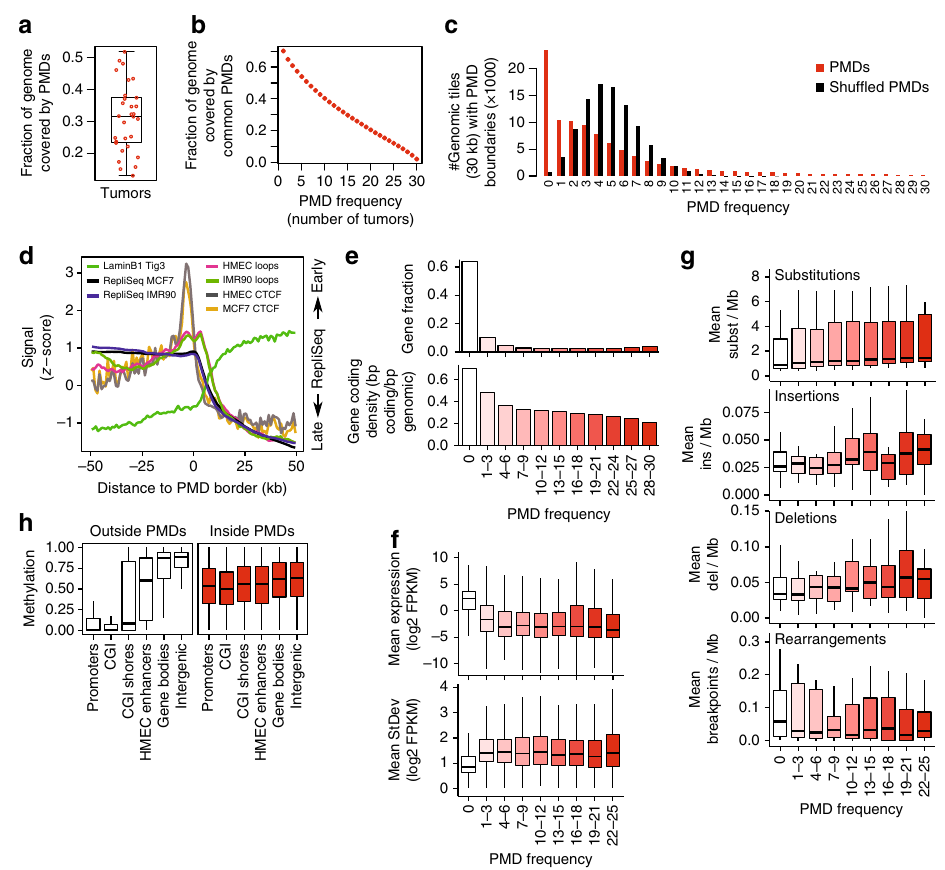
Fig. 2 Characterization of breast cancer PMDs. a Fraction of the genome covered by PMDs. Each dot represents one tumor sample, the boxplot summarizes this distribution. b Fraction of the genome covered by PMDs that are common between breast tumors. PMD frequency: the number of tumors in which a genomic region or gene is a PMD. c Breast cancer PMDs are not distributed randomly over the genome. The genome was dissected into 30-kb tiles, PMD frequency (number of boundaries) was calculated for each tile. The same analysis was done after shuf fl ing the PMDs of each tumor sample. d Average pro fi les of LaminB 23 , repliSeq (DNA replication timing, ENCODE), 3D chromatin interaction loops (HiC 27 , and CTCF (ENCODE) over PMD borders. If available, data from the breast cancer cell line (MCF7) and mammary epithelial cells (HMEC) was used, otherwise data from fi broblasts (IMR90, Tig3) was used. e Gene distribution inside PMDs (top, as a fraction of all annotated genes; bottom, as gene coding density). f Gene expression inside PMDs. Gene expression (top) and standard deviation (bottom) for the 25 overlapping cases of our WGBS and the transcriptome cohorts 17 was plotted as a function of PMD frequency. g Somatic mutations inside PMDs. Substitutions, insertions, deletions, and rearrangements were calculated for the 25 overlapping cases of our WGBS and the breast tumor full genomes cohorts 15 , and plotted as a function of PMD frequency. h Distribution of DNA methylation over functional genomic elements, inside and outside PMDs. CpGs were classi fi ed according PMD status and genomic elements, and the distribution of DNA methylation within each element was plotted. All boxplots in this fi gure represent the median and 25th and 75th percentiles,